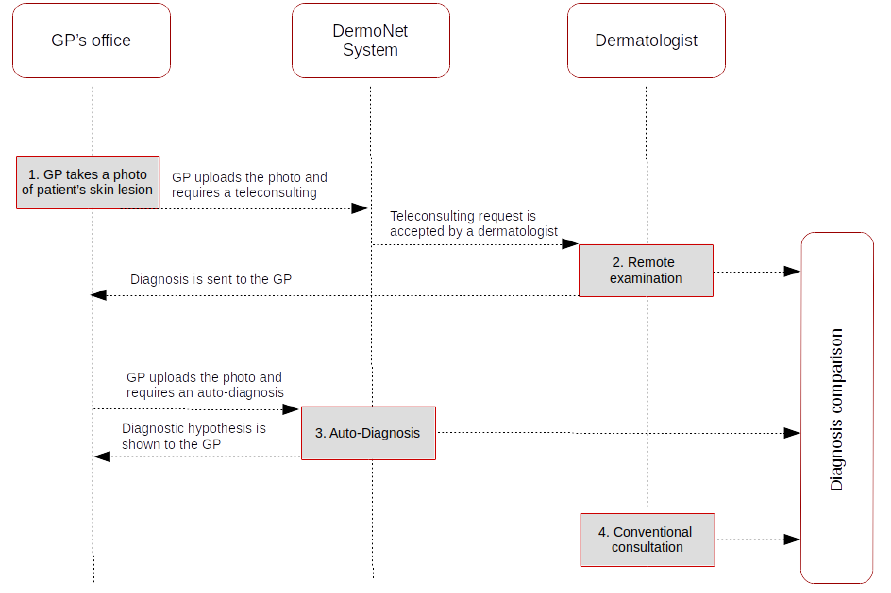
Figure 3. Diagnosis procedures: two use cases. GP: general